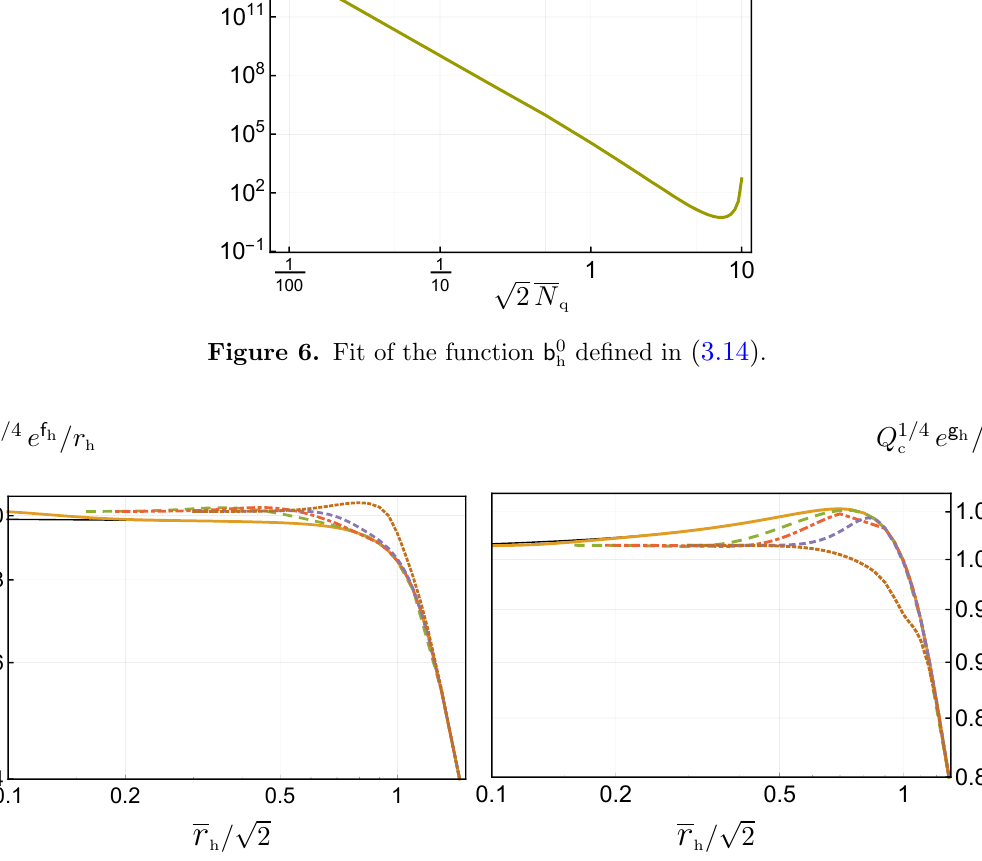
Figure 7. IR coe(cid:14)cients f